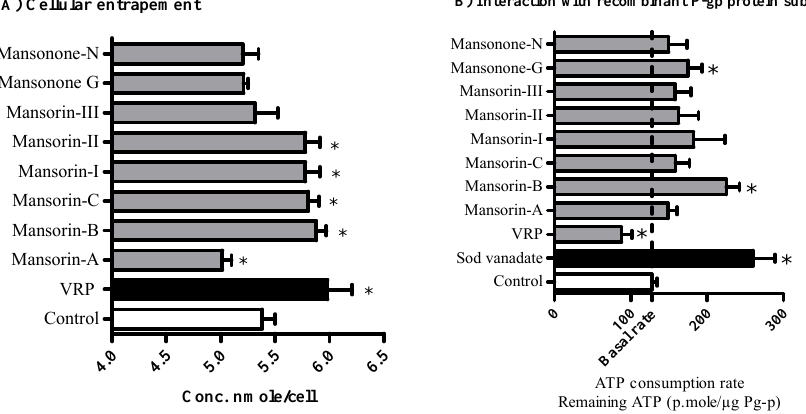
Figure 2. The effect of isolated compounds on the activity of P-glycoprotein efflux pump within HCT-116 cells ( A ) and in cell free isolated recombinant P-gp protein ( B ). Data is presented as mean ± SD; n = 3. (*): significantly different from CCl 4 treated group.